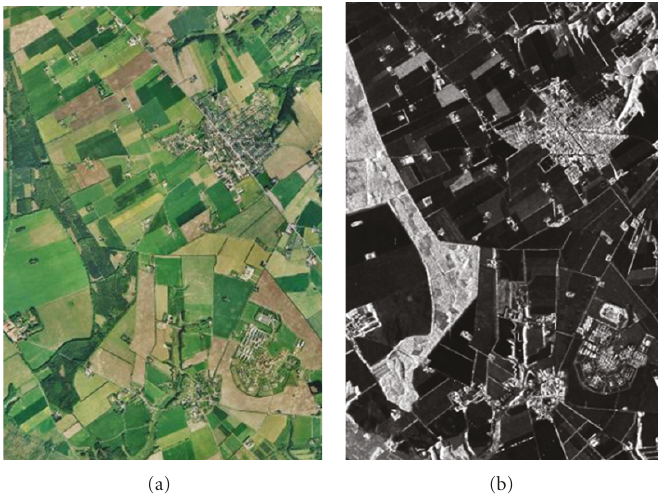
Figure 2: EMISAR test data of Foulum Area (DK): (a) optical image, (b) HH channel